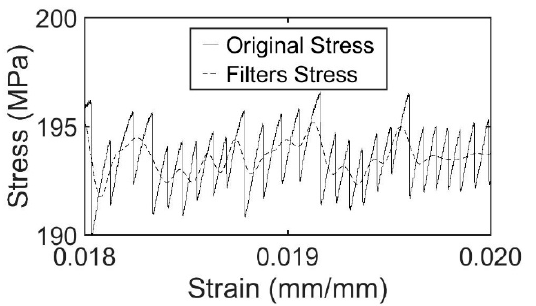
Figure 8. Part of the stress-strain curve generated by the Al–0.5 wt. % Mg–20 wt. % A206/1.0 wt. % γ Al 2 O 3 wires and the stress-strain curve as-filtered.